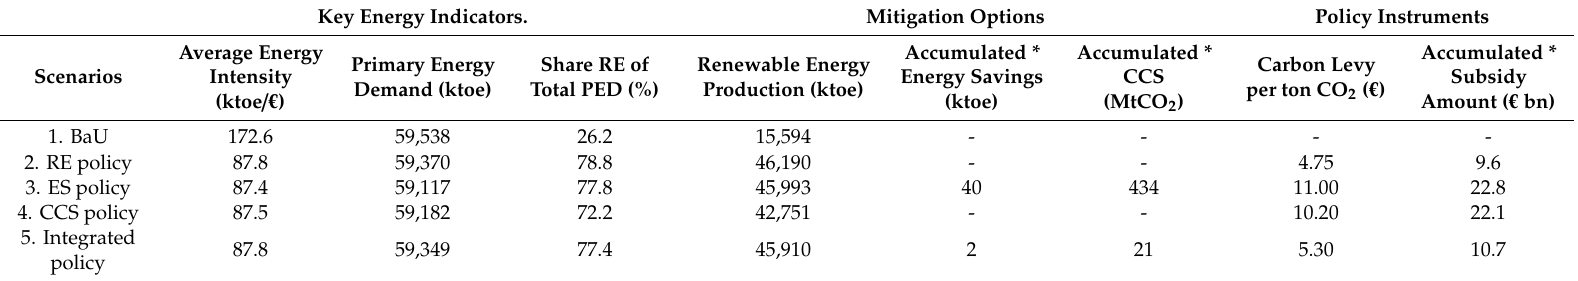
Table 5. Simulation results e ff ect policy instruments and mitigations options on primary energy demand (PED) and energy mix in 2050 (* accumulated over 2021 to